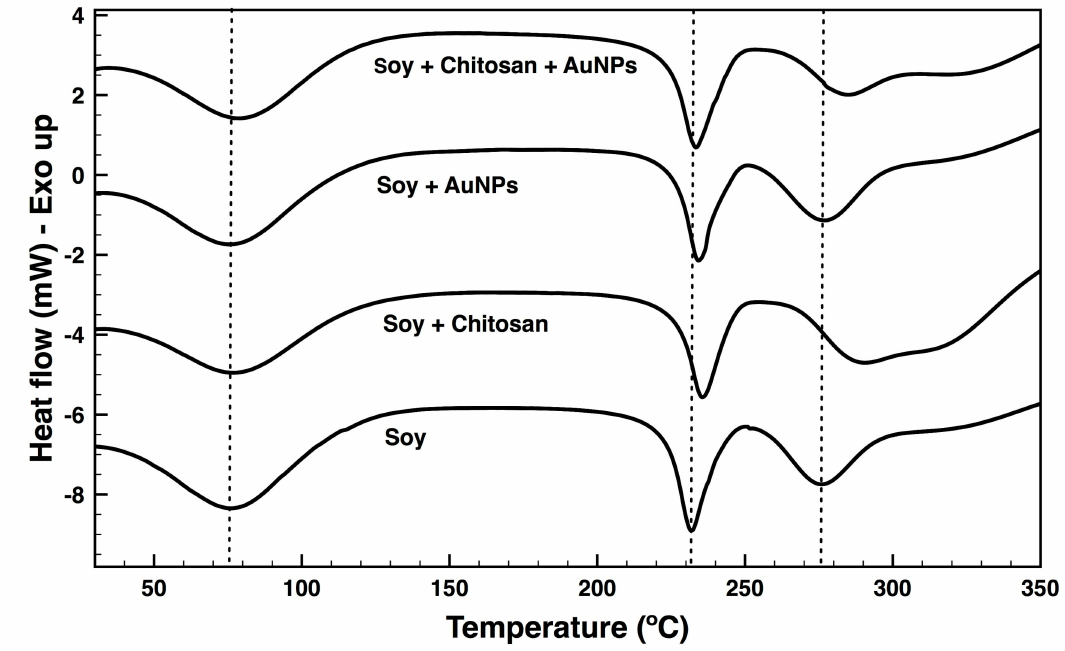
Figure 7. DSC thermograms of soybean fabrics bare and coated with chitosan and / or AuNPs in